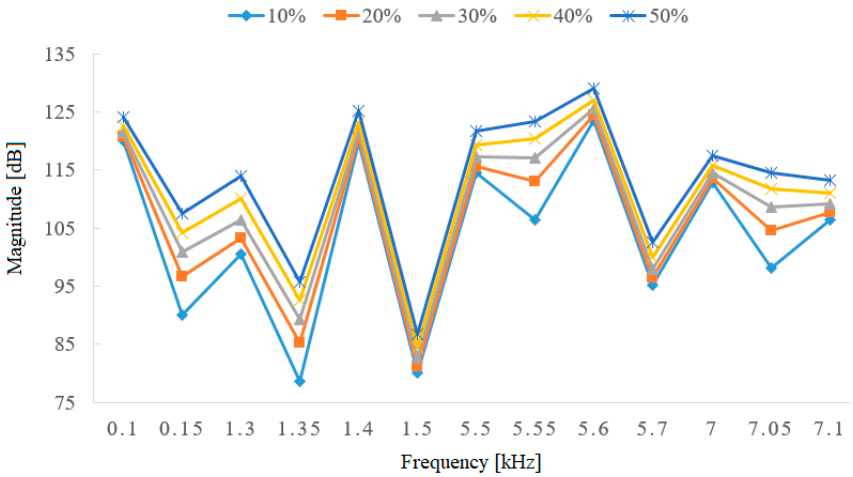
Figure 19. Different rotor dynamic eccentricities on motor vibration response.